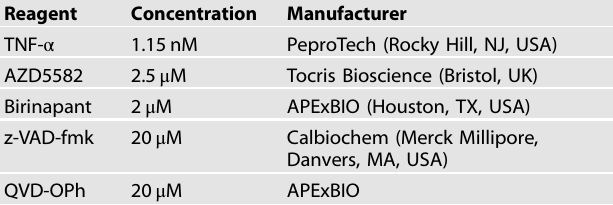
Table 1. Concentrations of reagents used to induce cell